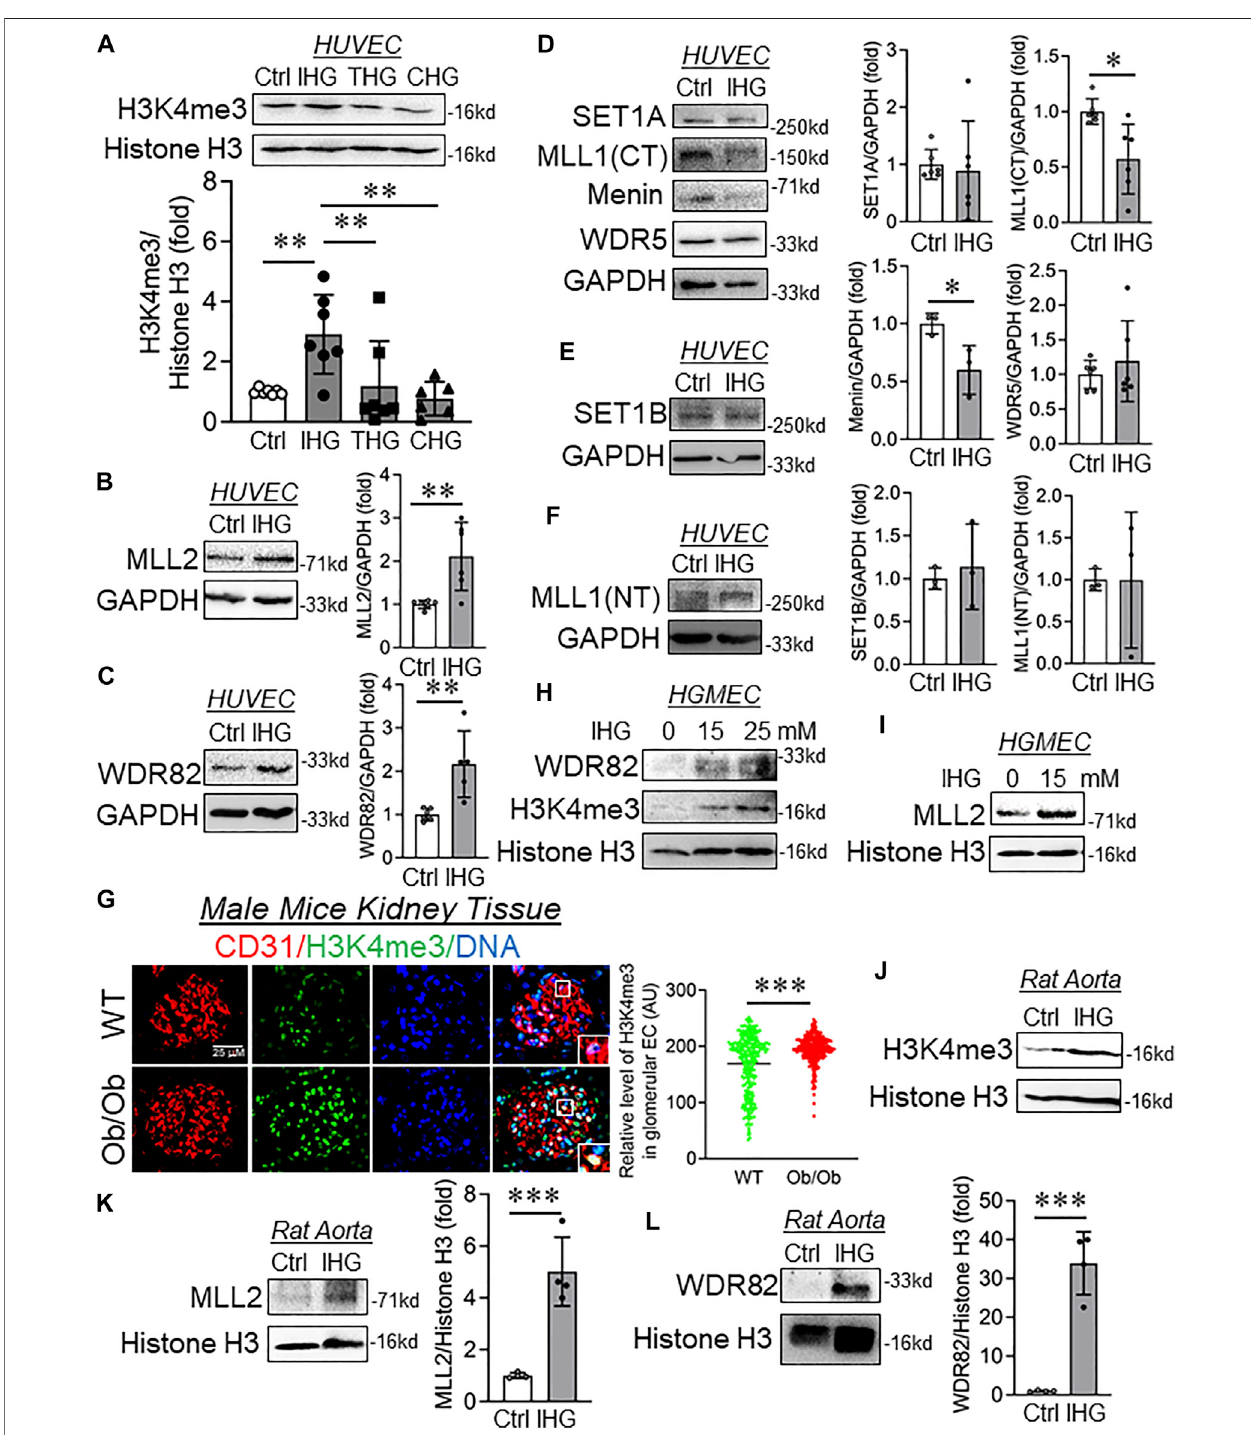
FIGURE 2 | Intermittent hyperglycemia caused increased levels of H3K4me3 through upregulation of MLL2 and WDR82. (A – F) Immunoblot analysis of HUVEC lysatescollectedfromcellstreatedwithdifferential/intermittenthigh-glucosetreatmentconditionsandprobedforH3K4me3( A , n =7),MLL2( B , n =6),WDR82( C , n =5), SET1A ( D , n = 5), MLL1 (CT) ( D , n = 6), Menin ( D , n = 3), WDR5 ( D , n = 6), SET1B ( E , n = 3), and MLL1 (NT) ( F , n = 3). (G) Immunohistochemistry of tissue sections from control and Ob/Ob mice stained for H3K4me3 and CD31( n =6). Fluorescence intensity AU values per individual cell nucleus are indicatedtogether withthe mean. Total number of nuclei, n ≥ 150. (H , I) Immunoblotting for H3K4me3 (H) , WDR82 (H), and MLL2 (I) in cultured HUVEC exposed to intermittent high glucose with a high- glucoseconcentrationof15and25 mM( n =3). (J – L) Immunoblotanalysisofrataortatissuelysatescollectedfromcellstreatedwithintermittent high-glucosetreatment conditions and probed for H3K4me3 (J) , MLL2 (K) and WDR82 (L) along with their respective densitometry quanti fi cation. Values represent the mean ± SD. * p < .05, ** p < .01, and *** p < .001, either by unpaired t -test for two groups or the two-stage linear step-up procedure of Benjamin, Krieger, and Yekutieli test for comparisons of multiple